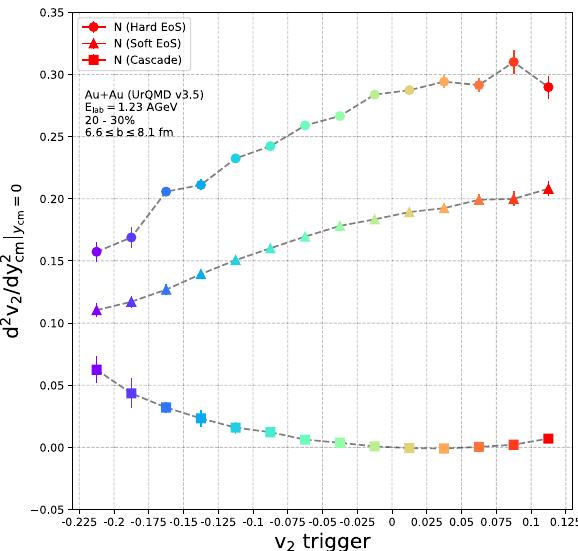
Fig. 4 The curvature of the elliptic flow component v 2 of nucleons at y cm = 0 as a function of the final state elliptic flow v 2 (colored full symbols) integratedover − 0 . 5 ≤ y cm ≤ 0 . 5 fora hardEoS (circles), asoft EoS (triangles) and in cascade mode (squares) from 20–30% peripheral Au+Au collisions at 1.23 AGeV from